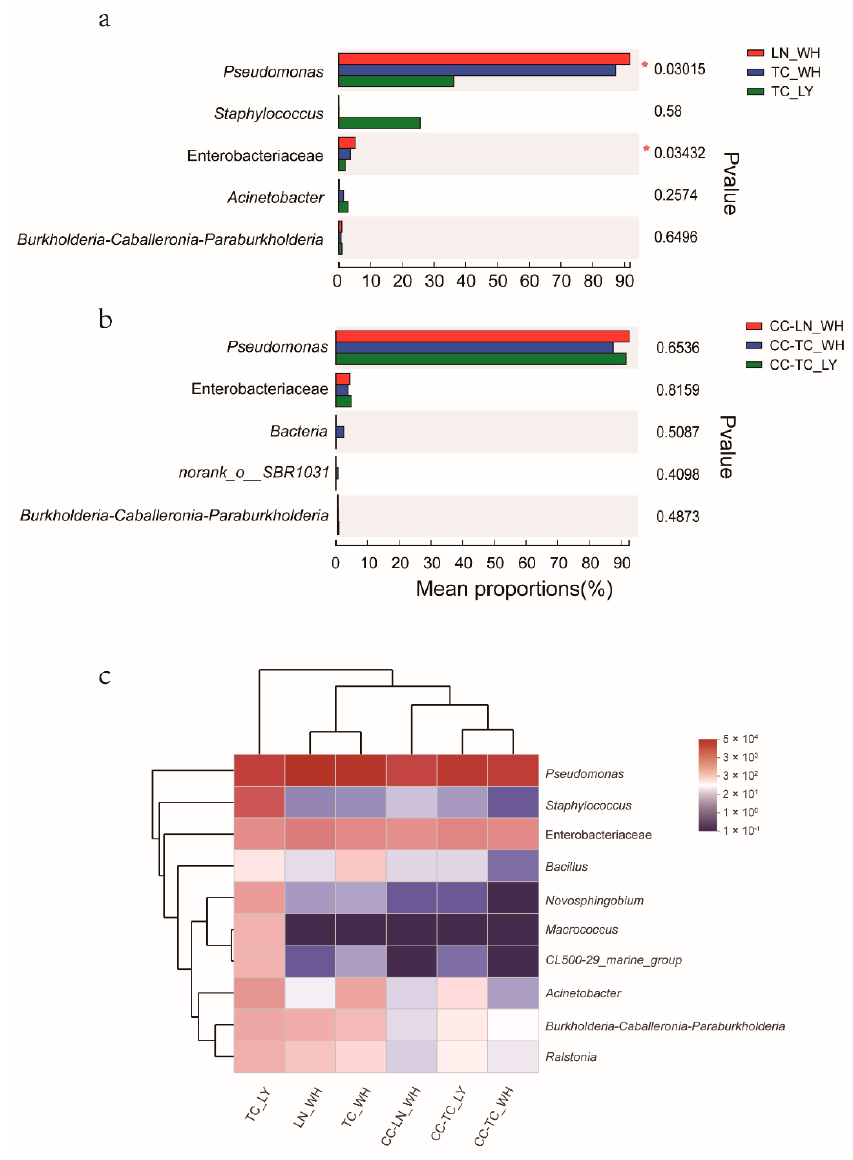
Figure 5. Comparison of the top five most abundant genera in ants ( a ) and spiders ( b ). *, p ≤ 0.05. Heatmap ( c ) shows the relative abundances of the ten most abundant genera in the six sample groups. Dendrograms for hierarchical cluster analysis grouping genera and sample locations are shown at the left and top, respectively. The color scale represents the normalized values of relative abundances by log10. Zero values were added as 1 and log10 transformed. TC_LY, T. caespitum Luoyang; TC_WH, T. caespitum Wuhan; LN_WH, L. niger Wuhan; CC-, spiders fed different diets.